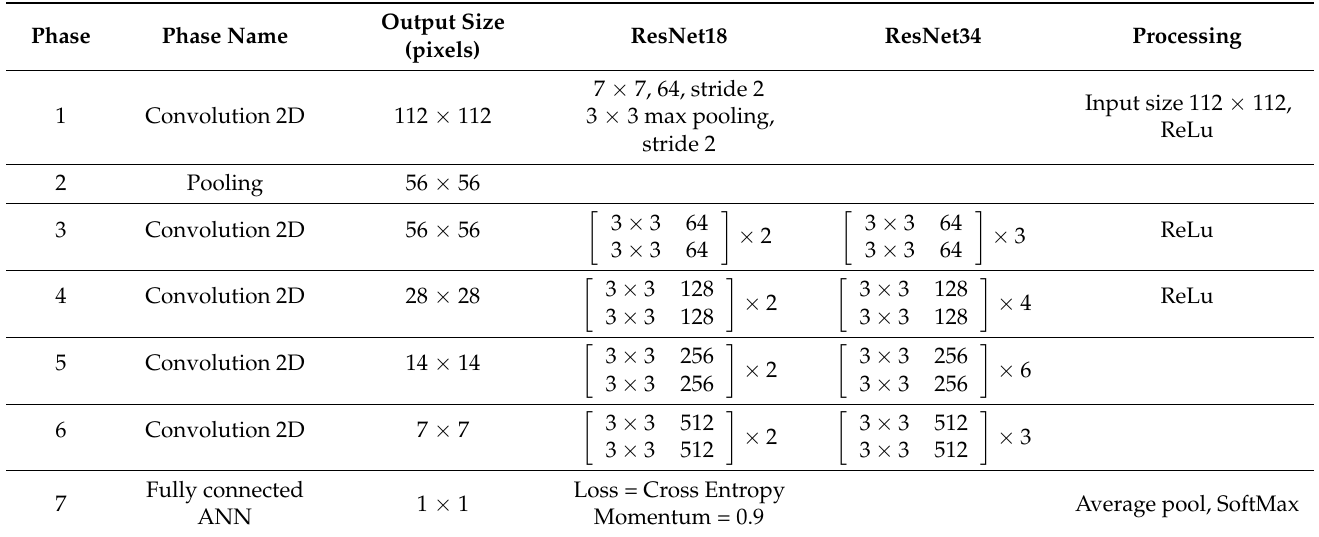
Table 2. Architecture of 7-phase deep residual learning network used in this